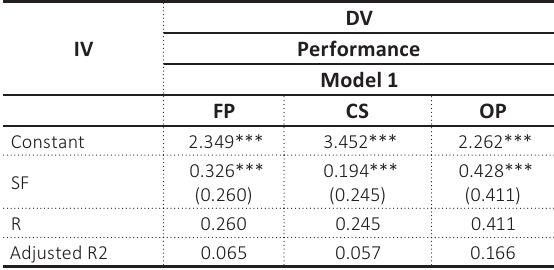
Table 5. Regression analysis of total SF: Performance dimensions